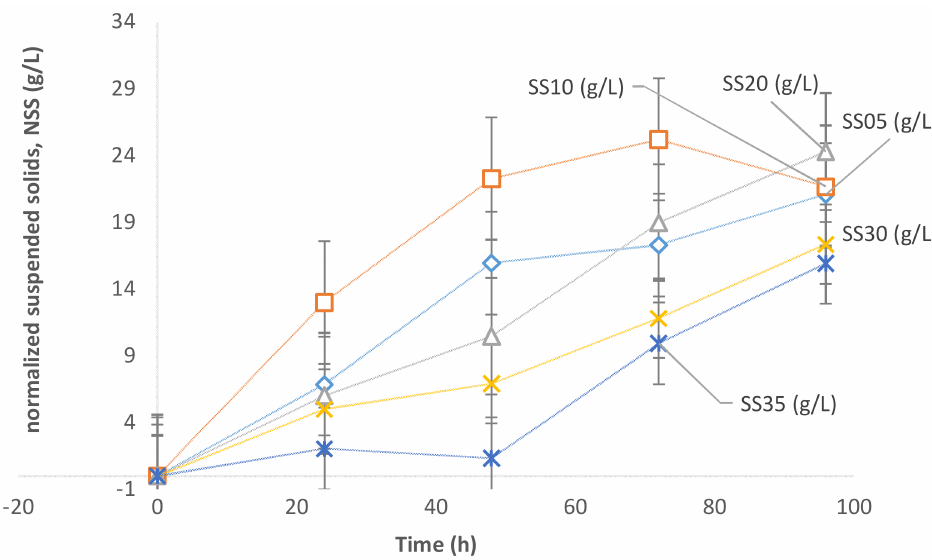
Figure 1. Net suspended solids (NSS) profiles for flask fermentation with different sludge solid concentration 5, 10, 20, 30, and 35 g/L.